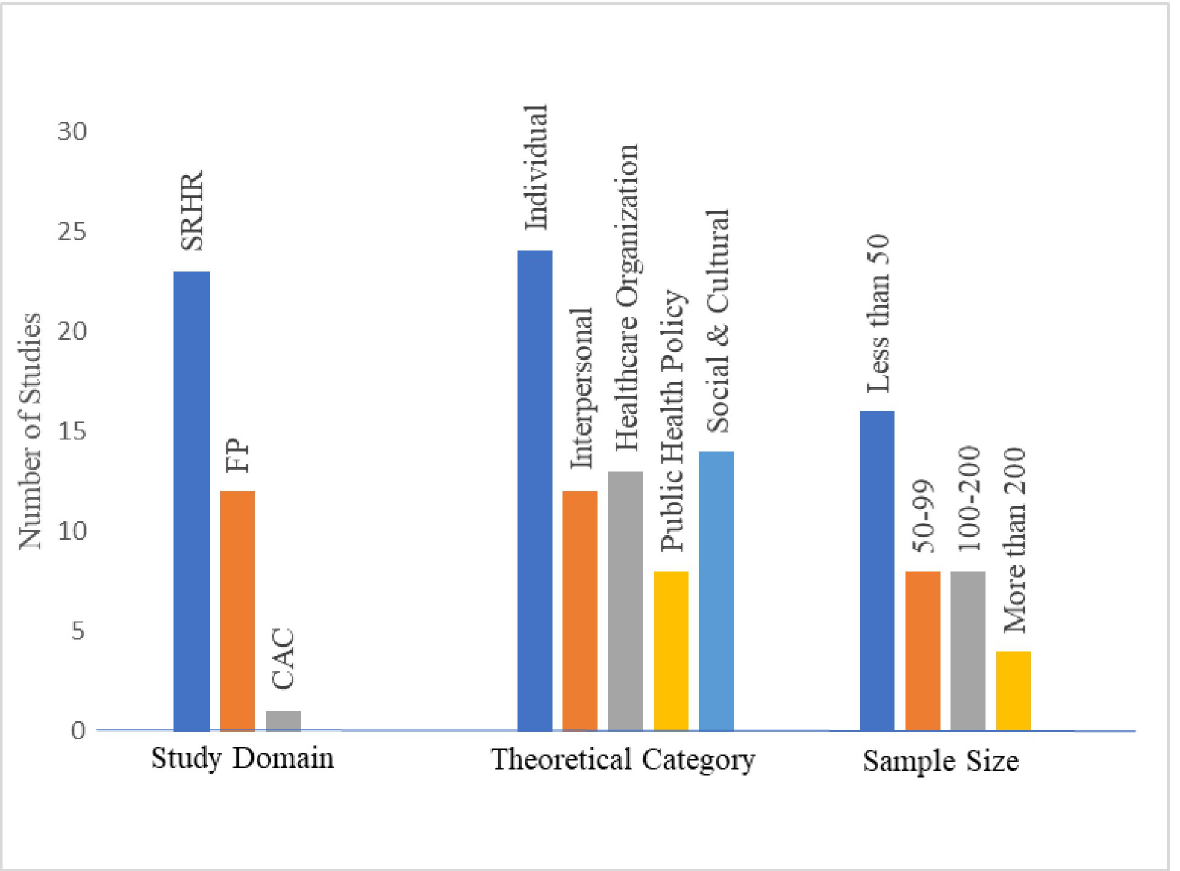
Fig 2. Ecological systems theory study